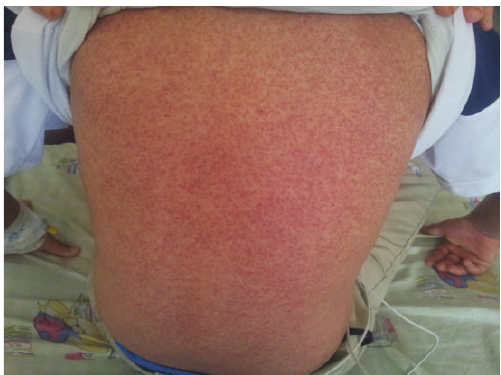
Figure 2: Generalised maculopapular rash on back.